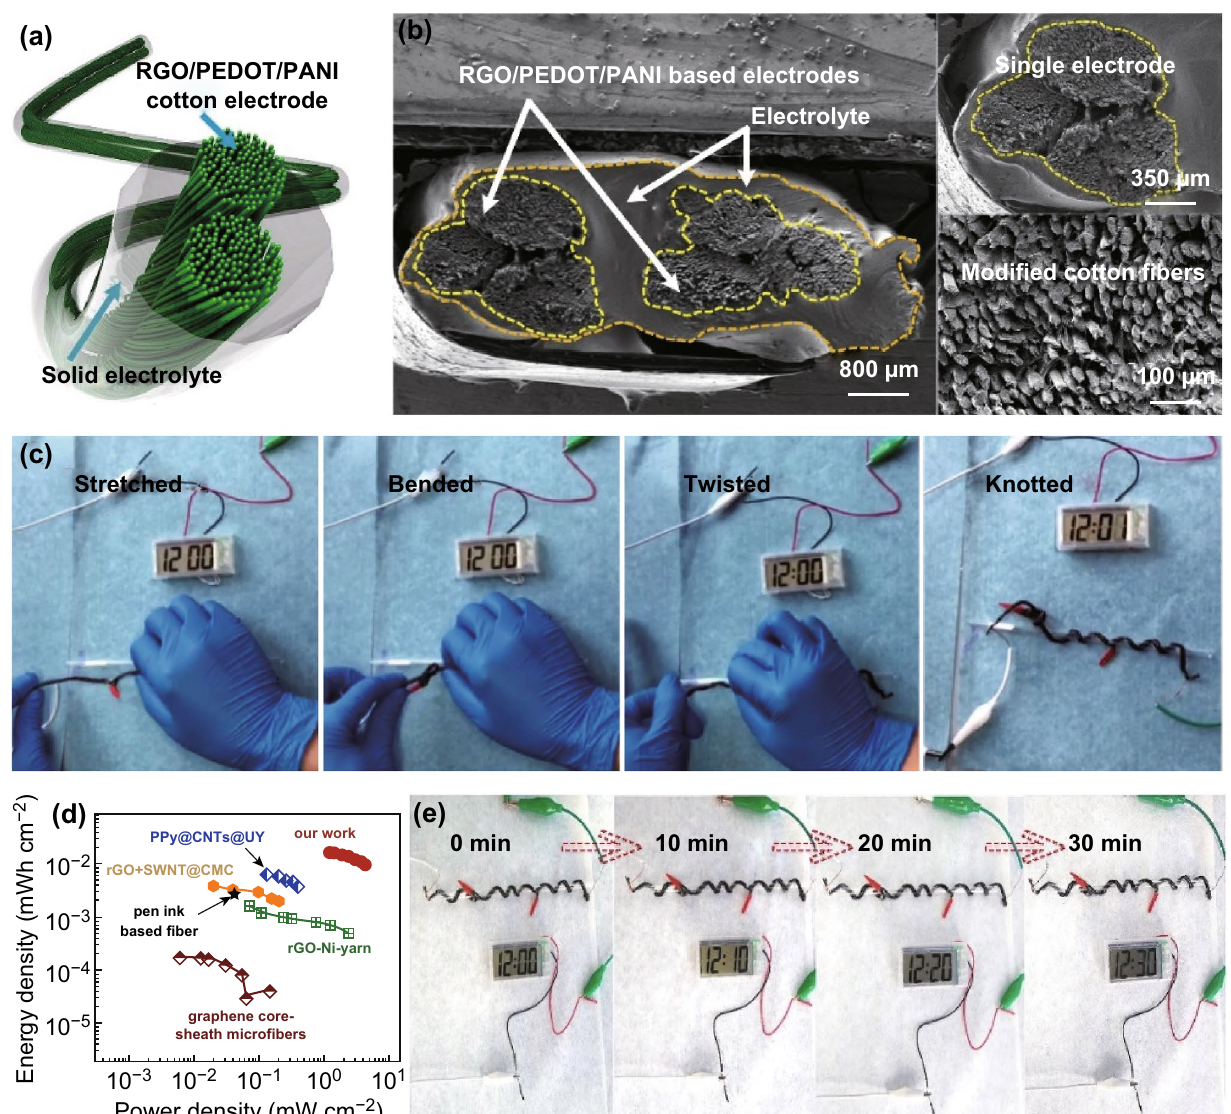
Fig. 7 a Schematic diagram of the linear SC device, b cross-sectional SEM images of the linear device based on RGO/PEDOT/PANI-modified cotton yarn, c the linear device can be stretched, bended, twisted, or knotted arbitrarily without damaging its integrity, while continuously pow- ering a digital watch, d Ragone plots of our linear SC and its comparison with other linear devices, and e three SCs connected in series can eas- ily power a digital watch for at least half an